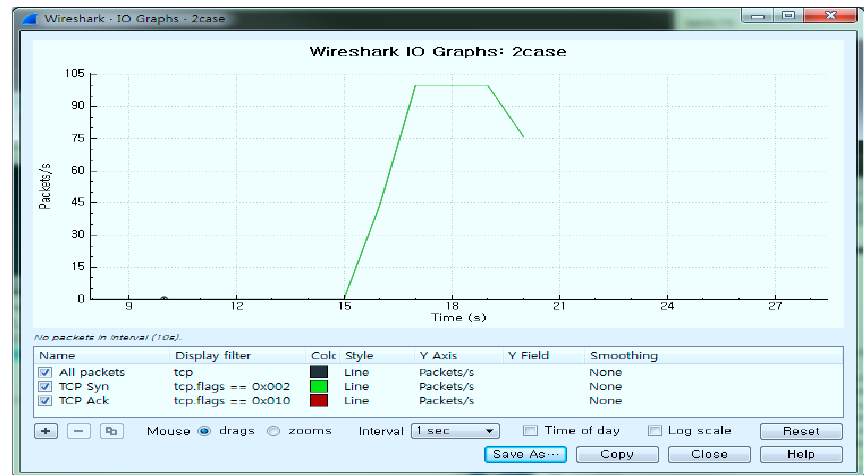
Figure 6. Experiments on M2M intelligent network device packet and operation ( a ) Air Cleaner, ( b ) 220v Plugin.